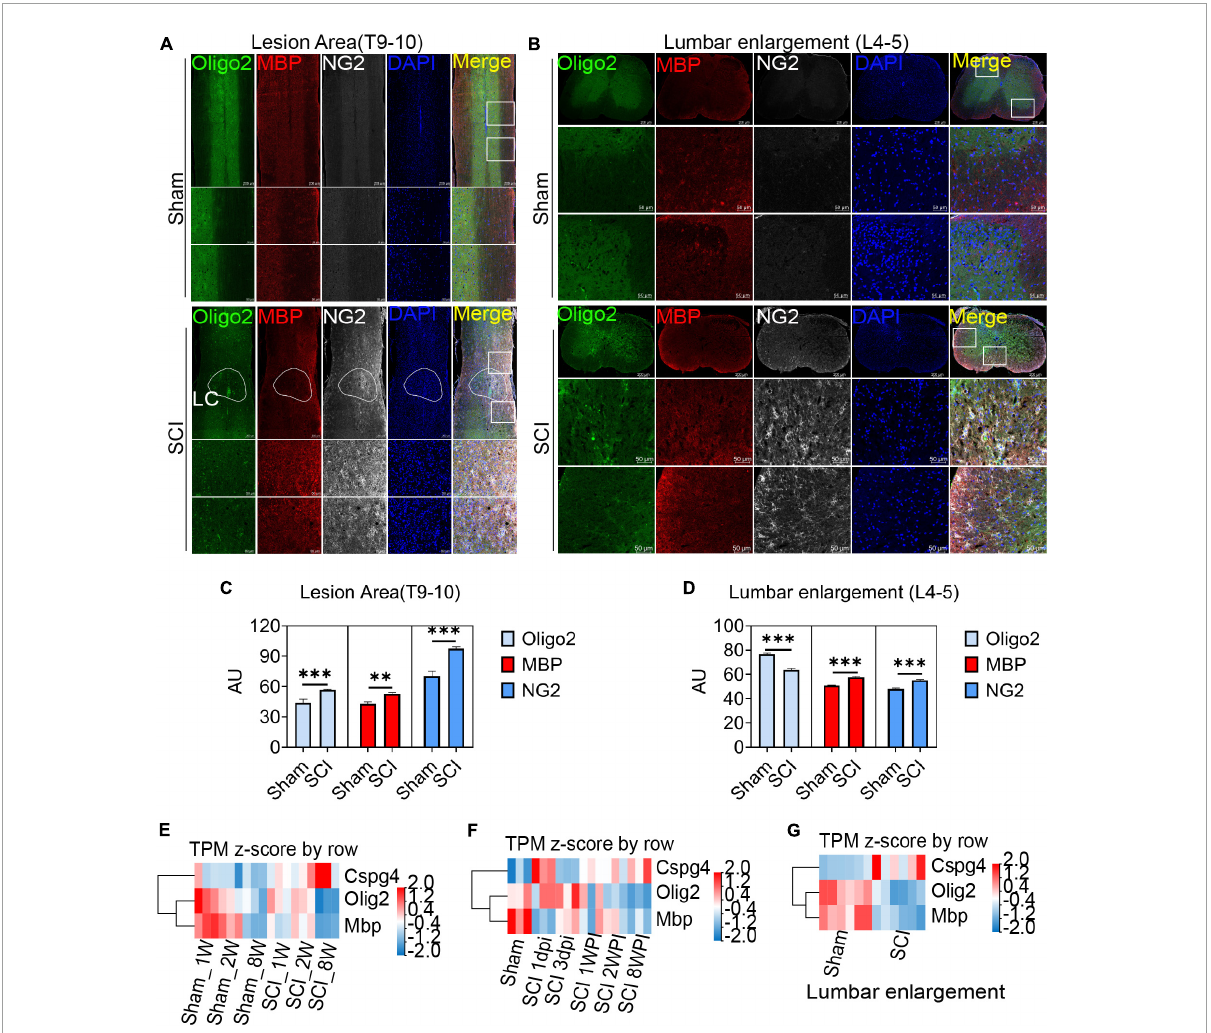
FIGURE4 Oligodendrocyte progenitor cells (OPCs) are activated in the lesion area and lumbar enlargement after SCI. (A,B) Immunofluorescence staining to detect the expression of oligodendrocyte lineage cell markers in the lesion area and lumbar enlargement after SCI. Olgio2 (green), MBP (red), and NG2 (white). n = 3 biological repeats. Scale bars are indicated in the pictures. LC = lesion core. (C,D) The histogram and statistical results of Oligo2, MBP, and NG2 fluorescence intensity. n = 3 biological repeats. Values are the mean ± SEM. Statistical significance was determined by one-way ANOVA followed by Student Newman–Keuls post-hoc test. ∗∗ P < 0.01, ∗∗∗ P < 0.001. (E–G) RNA-seq results showed transcript changes in oligodendrocyte lineage cells both in the lesion area and lumbar enlargement at different ages and time. dpi, day post-injury; WPI, week post-injury; 1 W, 1-week-old; 2 W, 2-week-old; 8 W, 8-week-old; sham_1 W, 1-week-old sham group; sham_2 W, 2-week-old sham group; sham_8 W, 8-week-old sham group; SCI_1 W, 1-week-old SCI group; SCI_2 W, 2-week-old SCI group; SCI_8 W, 8-week-old SCI